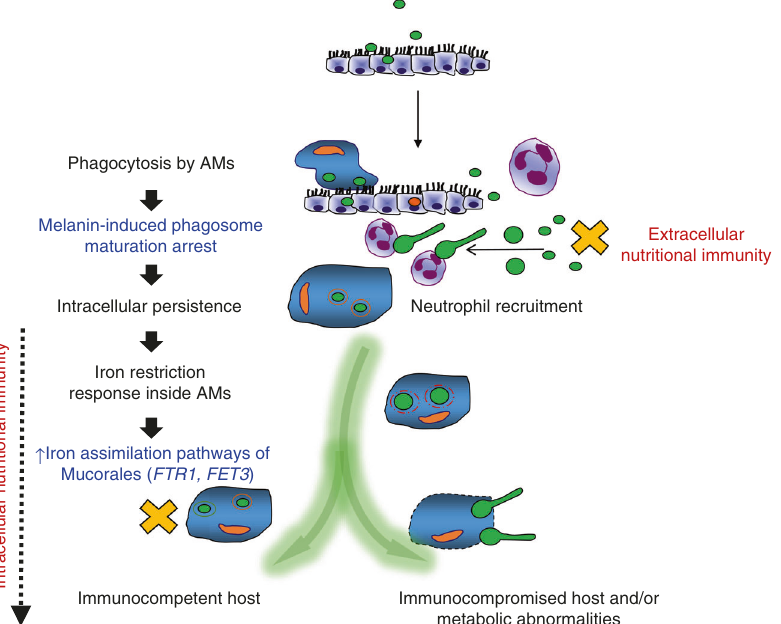
Fig. 10 Proposed model of nutritional immunity inside macrophages against Mucorales. Following inhalation, Mucorales conidia are predominantly phagocytosed by alveolar macrophages (AMs). Intracellular conidia of Mucorales remain dormant and establish prolonged persistence inside the nascent phagosome of AMs. Surface retention of cell wall melanin in intracellular conidia of Mucorales blocks phagosome biogenesis and LAP, impedes killing, and induces anti-apoptotic signaling in macrophages to establish persistence. Inhibition of intracellular germination of Mucorales conidia via iron restriction is a central host defense mechanism against mucormycosis. In addition, incompletely understood nutritional immunity mechanisms, including transferrin- mediated restriction of free iron availability in serum, inhibit germination of extracellular conidia. In parallel, rapid recruitment of neutrophils results in clearance of extracellular conidia of Mucorales. Quantitative and qualitative defects in innate immunity associated with prolonged chemotherapy-induced neutropenia, and/or corticosteroid-induced immunosuppression compromise the ability of phagocytes to inhibit germination of intracellular or extracellular conidia and result in invasive fungal growth. On the other site, failure of nutritional immunity mechanisms in patients with abnormalities on iron metabolism (e.g., diabetic acidosis) allow germination of intracellular or extracellular conidia and promote invasive tissue growth. Mucorales responses inside AMs are highlighted in blue. Nutritional immunity responses are highlighted in